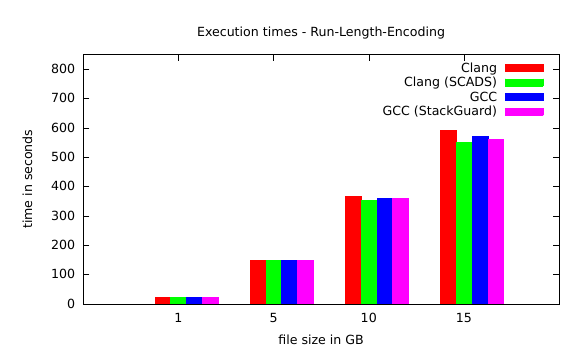
Figure 15. Execution times of the program defined by listing 19.